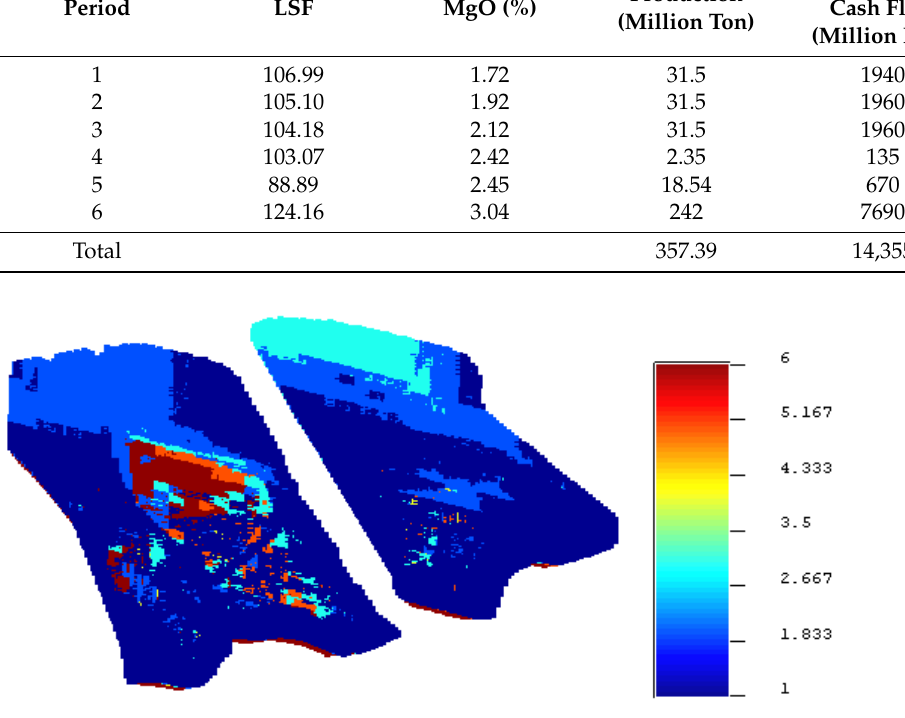
Figure 9. Model 1: the final ultimate pit of the relaxed solution (legend represents a period of ex- traction). Table 2. Production scheduling results from Model 1.